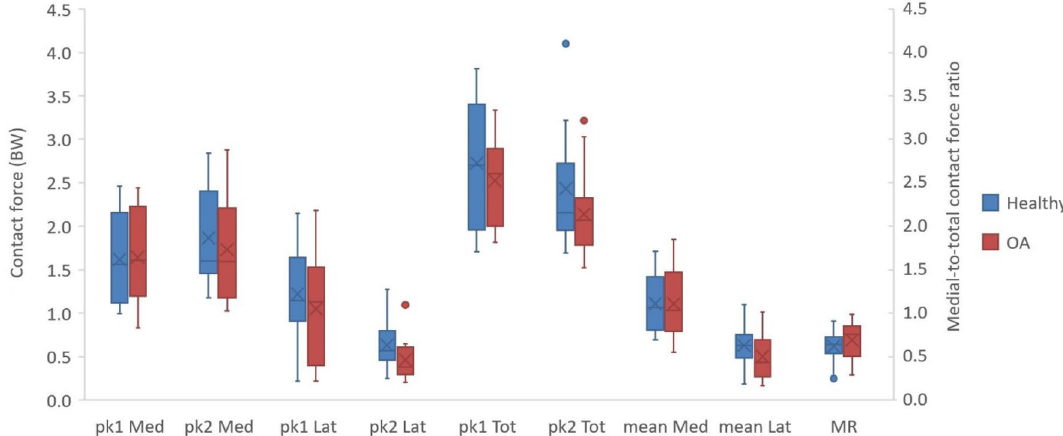
Figure 2. Box and whisker plot of contact forces of the healthy (blue) and OA (red) groups at the 1st and 2nd peaks of medial contact force (pk1 Med, pk2 Med), 1st and 2nd peaks of the lateral contact force (pk1 Lat, pk2 Lat), 1st and 2nd peaks of the total contact force (pk1 Tot, pk2 Tot), the average medial (mean Med) and lateral (mean Lat) contact forces during the stance phase, and the medial-to-total contact force ratio (MR) during the stance phase. The plot represents the minimum, maximum, lower and higher quartiles, and the median as well as the mean value (X mark), and the outliers (o